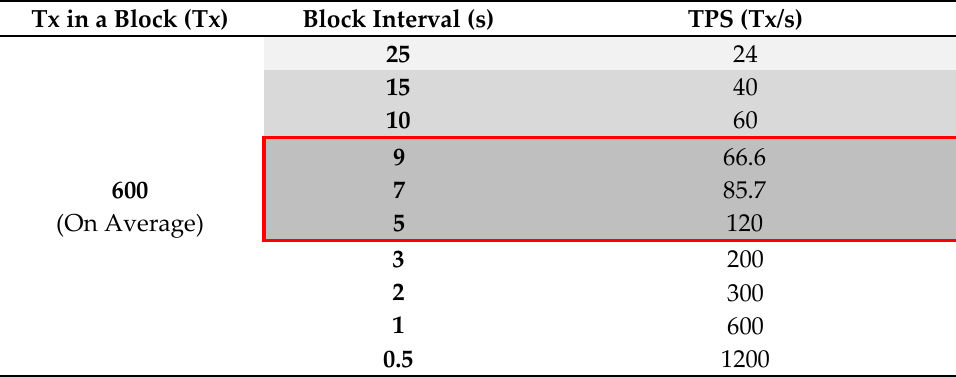
Table 7. Block Interval and TPS Results in Testnet.